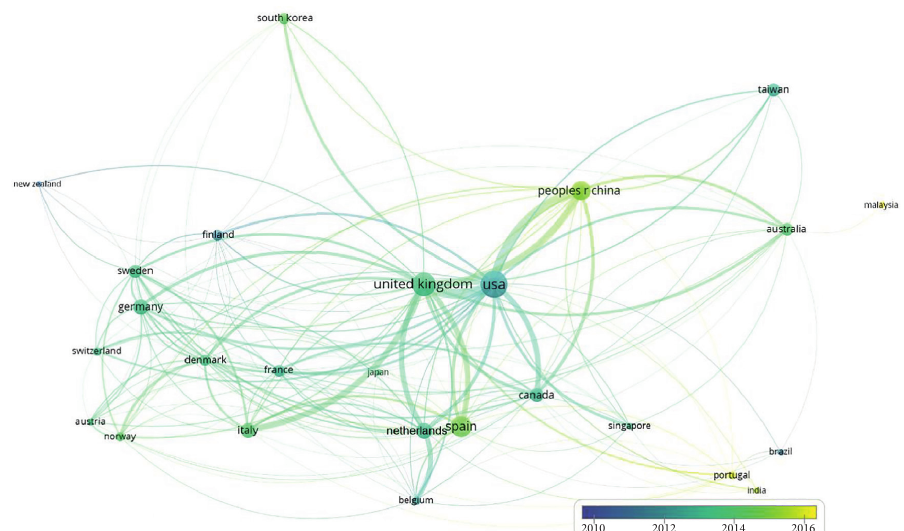
Figure 9: Temporal evolution of country networks. Source: own elaboration with Web of Science and Scopus data bib73(2018) processed with VOSviewer